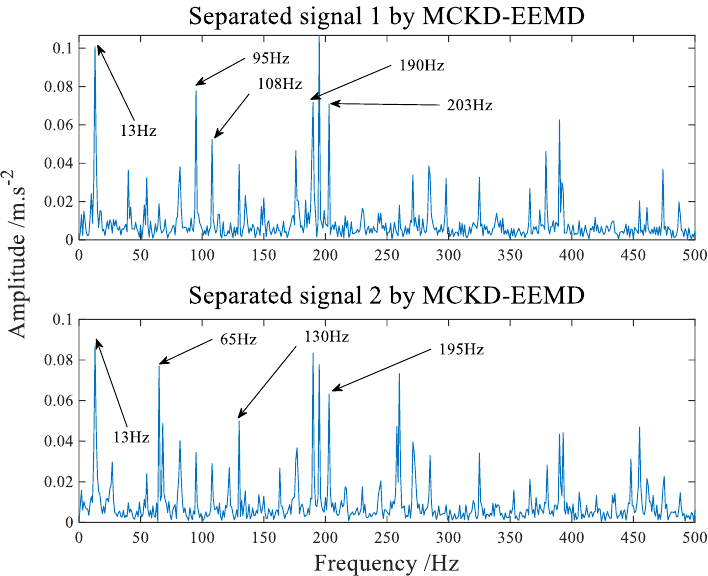
Figure 16. The frequency domain spectrum of separated signal processed by MCKD − EEMD.